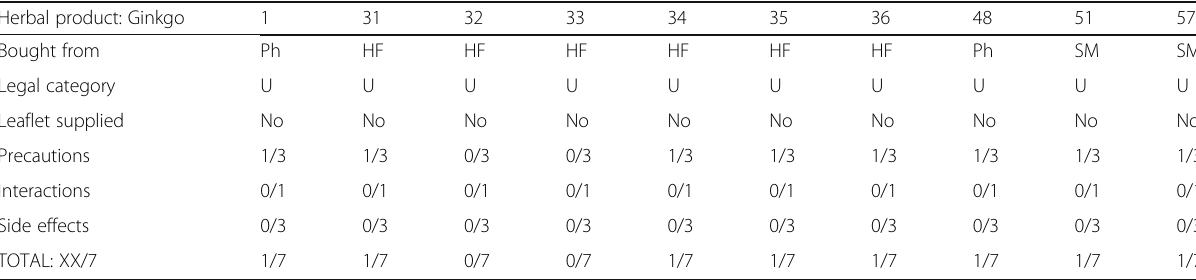
Table 3 Ginkgo Herbal product: Ginkgo